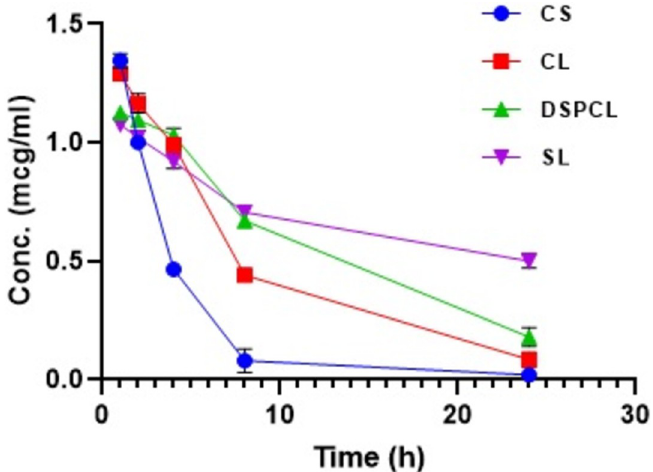
Fig 10. Plasma concentration-time profile of various CLB liposomes and free drug solution (data expressed as mean ± SD, n = 3). https://doi.org/10.1371/journal.pone.0264518.g010 CL and 17.34% of injected dose for DSPCL were noted to be residing in the spleen. It scored